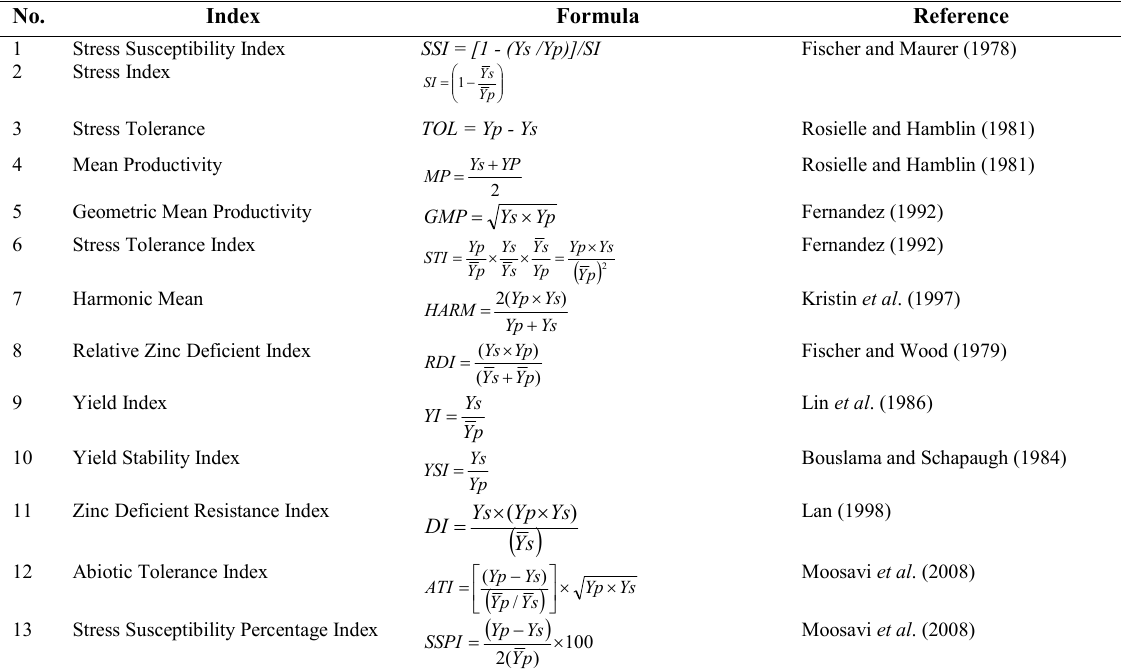
Table 2. List of zinc stress tolerance indices used in the